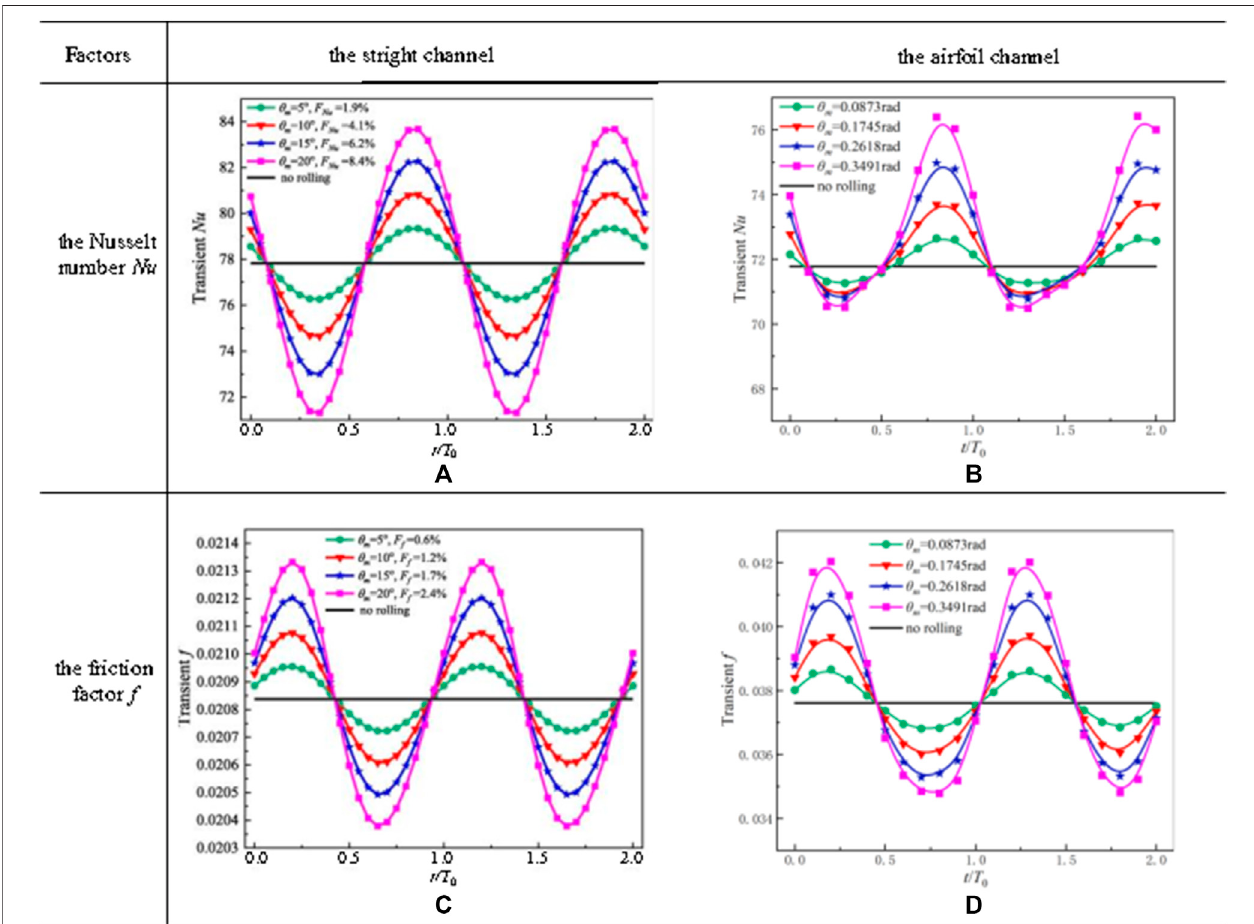
FIGURE 7 | Effect of heat exchanger structure on thermal and hydraulic performance (Chen et al., 2022; Tang et al., 2020).